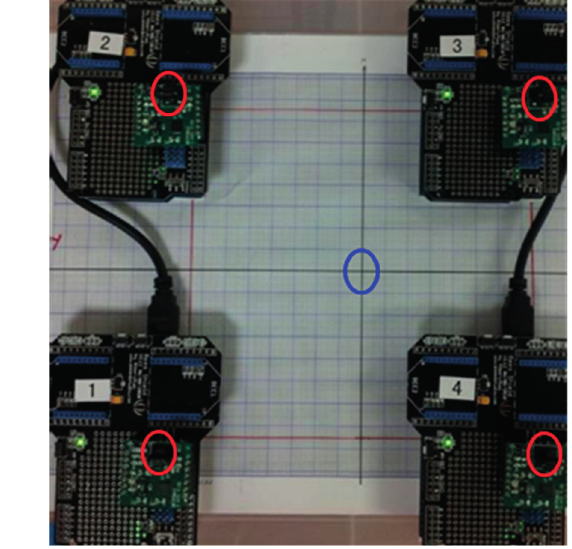
Figure 8. System setup with four 3-axis magnetic